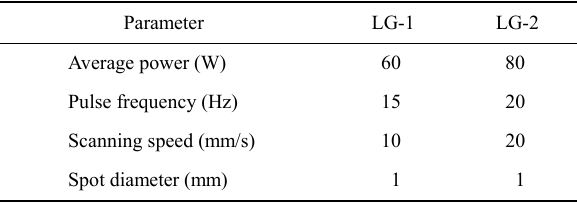
Table 2 Process parameters to fabricate the